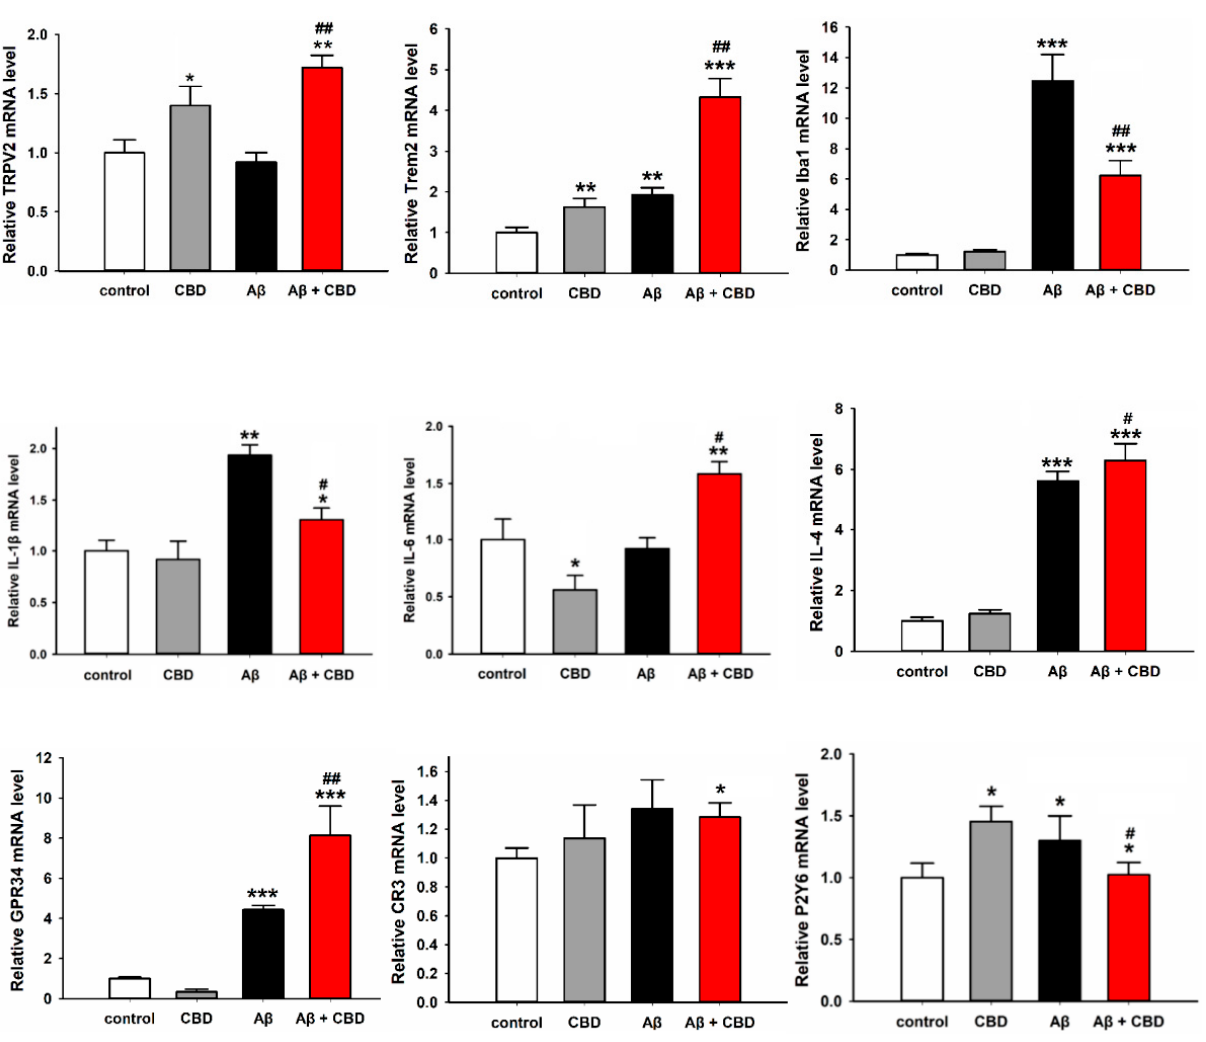
Figure 4. Relative mRNA levels of microglial phagocytic receptors and inflammation factors in the microglia cells treated with or without CBD (5 μ M). Primary microglial cells were treated with or without CBD after 12 h, and the mRNA levels were determined through qPCR. The data are represented as the mean ± SEM ( n = 6). * p < 0.05, ** p < 0.01, and *** p < 0.001 are compared with the control by Tukey’s test; # p < 0.05 and ## p < 0.01 are between A β and CBD + A β by Student’s t ‐ test.